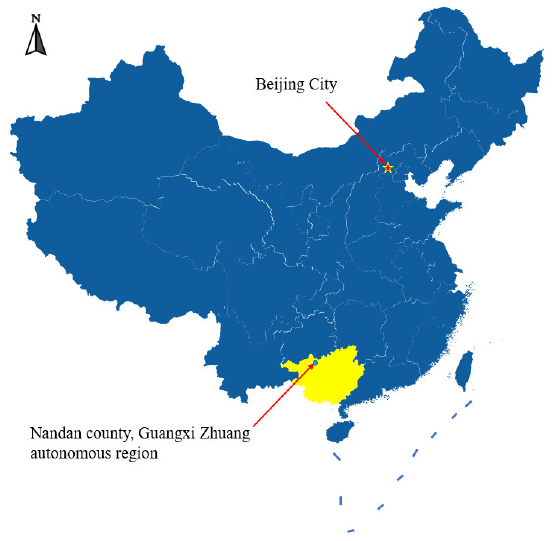
Figure 1. The location of the Gaofeng mine.